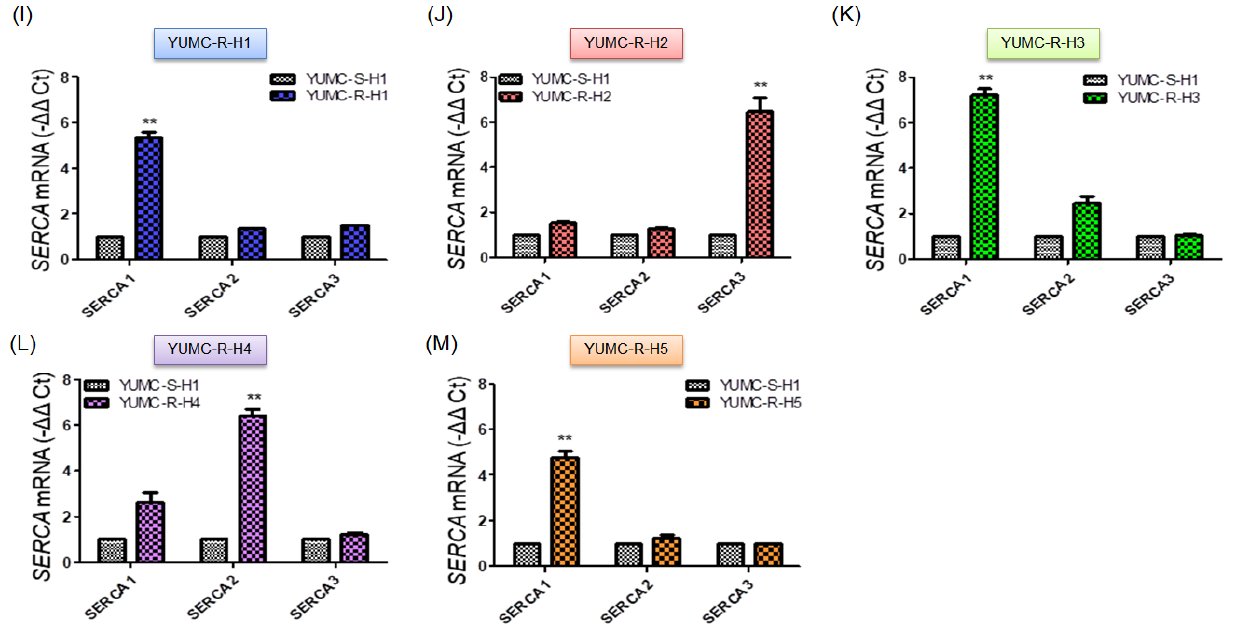
Figure 2. Features of patient − derived HCC cell lines. ( A ) Features of patient ‐ derived subtypes of drug ‐ sensitive and drug ‐ resistant HCC cell lines. ( B ) Hierarchical clustering of annotated genes revealed different gene expression. Differences in gene expression profiles between drug ‐ sensitive and drug ‐ resistant HCC cells. ( C – G ) Bar plot showing 20 markedly upregulated pathways in YUMC − R − H1, − H2, − H3, − H4, and ‐ H5 compared with those in YUMC − S − H1. ( H ) Immunoblot analysis of SERCA levels in HCC cells. ( I – M ) qRT − PCR and mRNA expression of SERCA family genes of drug ‐ resistant HCC cells compared with those of drug ‐ sensitive HCC cells. ** p < 0.01 versus anti ‐ cancer drug ‐ sensitive HCC cells, YUMC ‐ S ‐ H1.